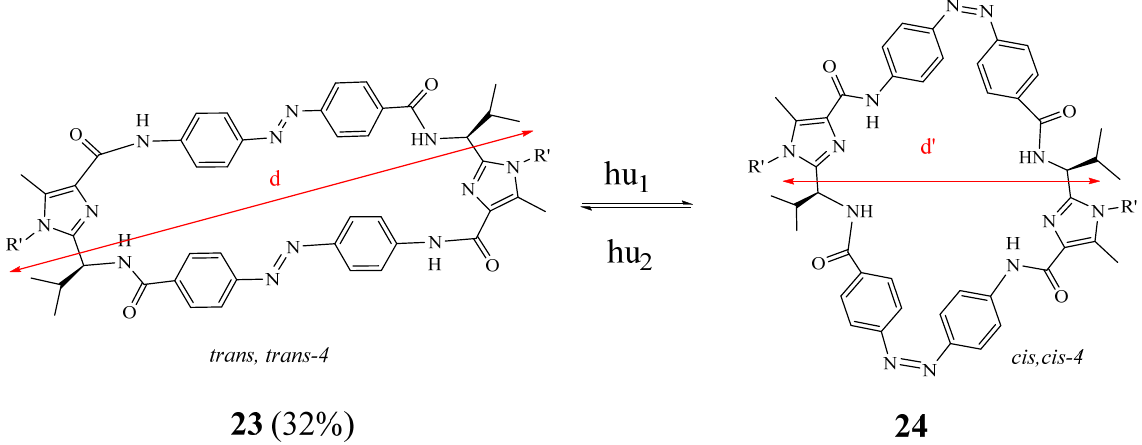
Figure 5. Structures of macrocycles 15 − 22. (Reprinted with permission from ref. [20]. Copyright 2011 Elsevier).